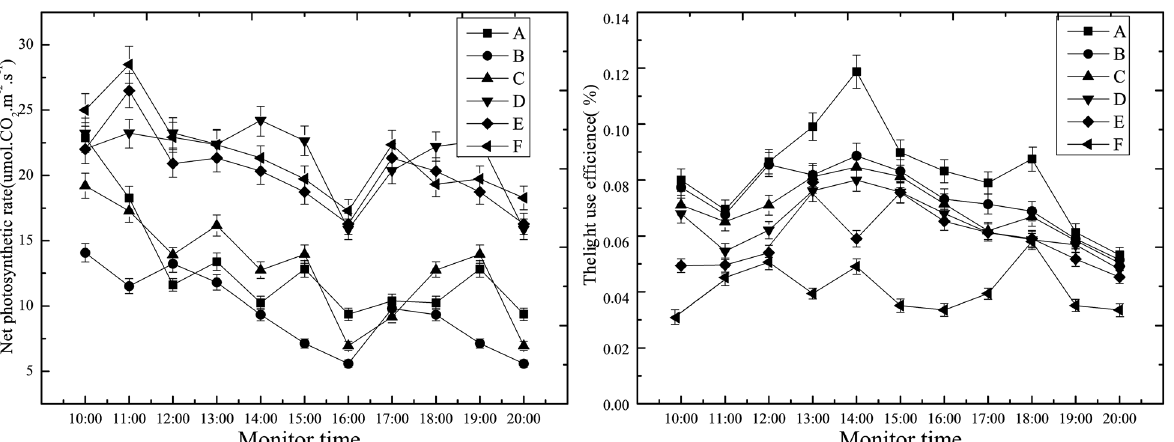
Fig 7. Effect of different salt dust treatments on the net rate of photosynthesis ( P n ) and efficiency of light use ( PE ) by the cotton leaves.